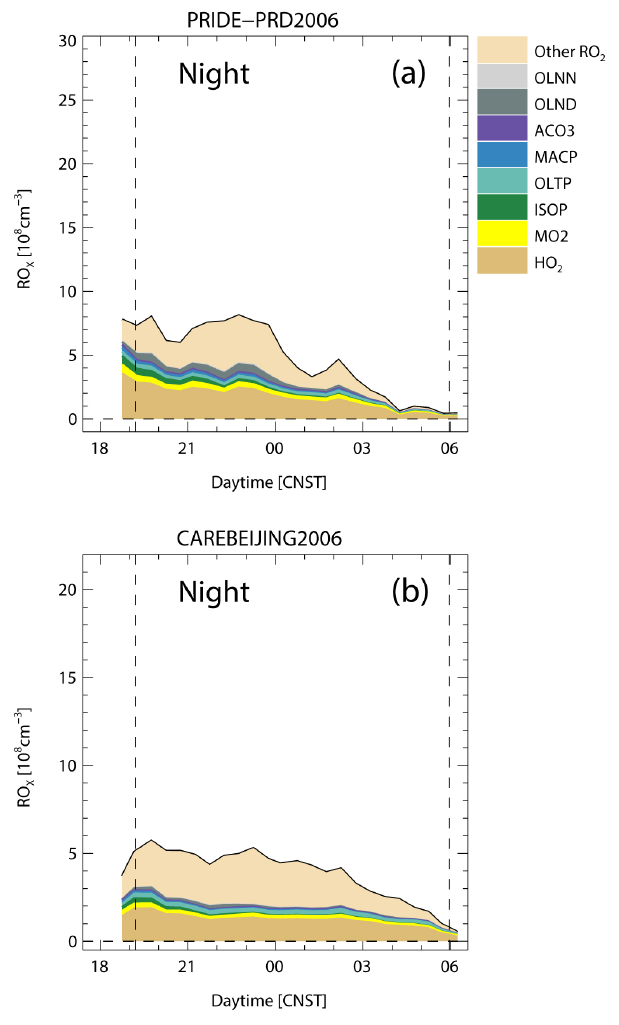
Figure 11. Modeled (M0+X+ p OH ) peroxy radical ( = RO 2 + HO 2 ) concentrations and their speciation at